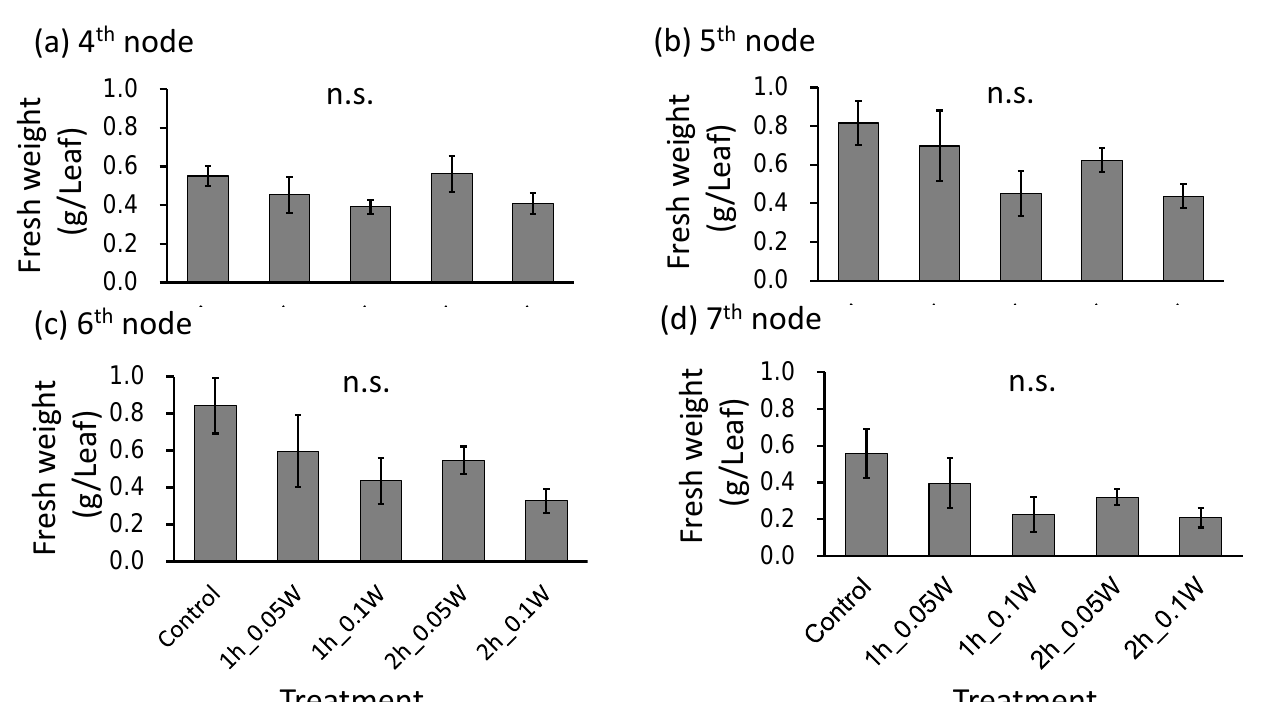
Figure 7. Effect of exposure to intermittent nocturnal lighting for 6 h with UV-B light on leaf fresh weight in red perilla plants (Experiment 3). Perilla plants were irradiated for 1 or 2 h every 1 or 2 h for 6 h, from 18:00 to 06:00. The UV-B radiation intensity at the canopy level was set to 0.05 or 0.1 W m − 2 . The integrated UV-B per night at 0.05 and 0.1 W m − 2 was 1.1 and 2.2 kJ m − 2 day − 1 , respectively. Leaves at the 4th node counted from the bottom of the main stem were harvested 1 week after treatment initiation; thereafter, leaves at the 5th, 6th, and 7th nodes were sampled from the same plants at 2, 3, and 4 weeks after treatment initiation. Vertical bars indicate SE ( n = 5). n.s. indicates no significant difference as per the Tukey-Kramer test.